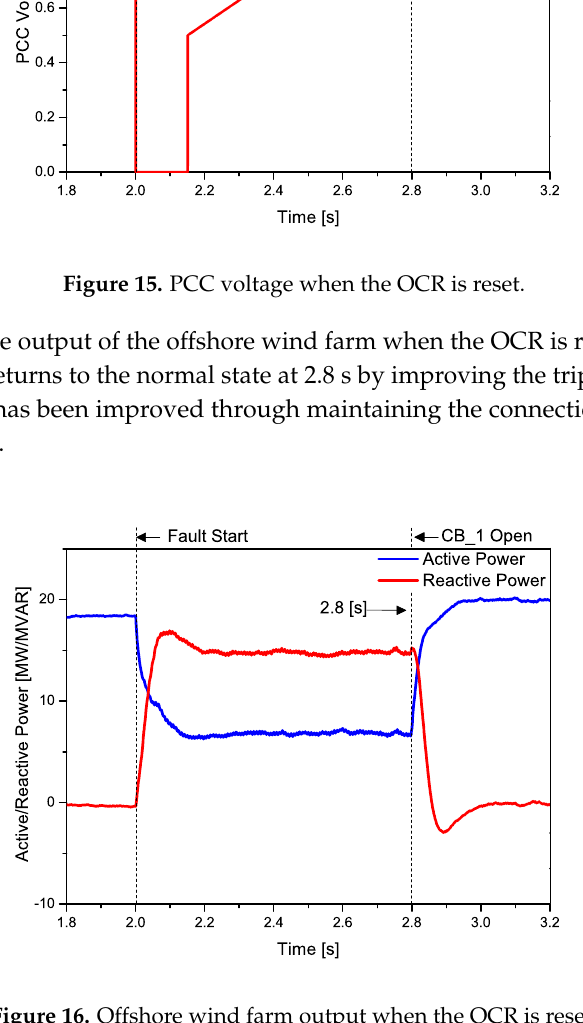
Figure 16. Offshore wind farm output when the OCR is